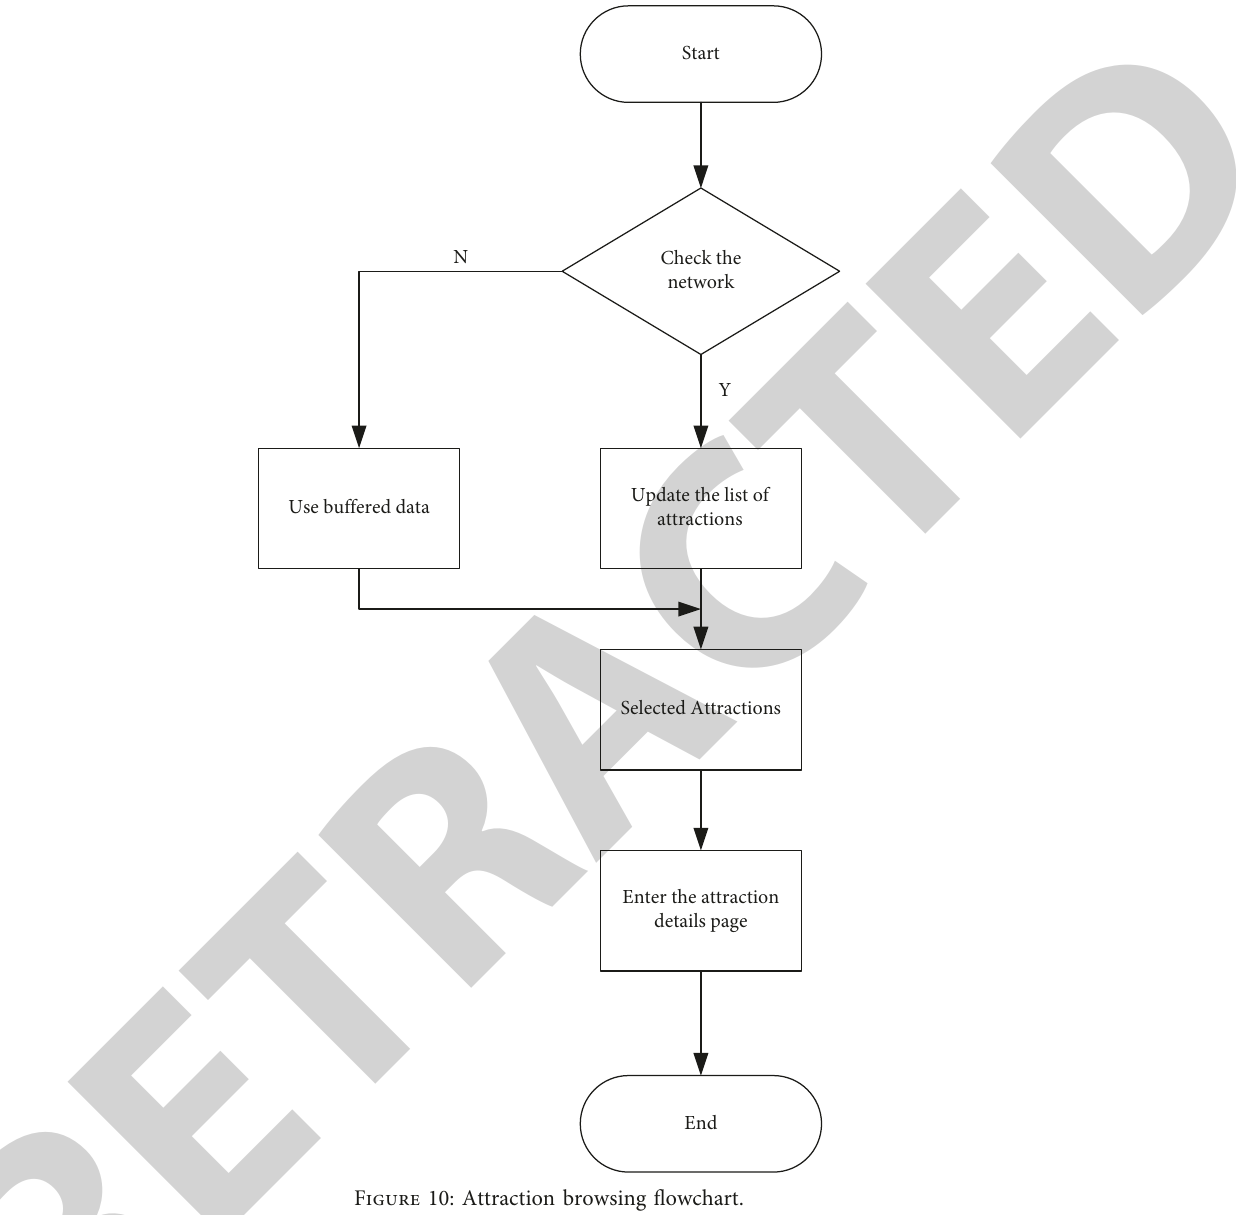
Figure 10: Attraction browsing